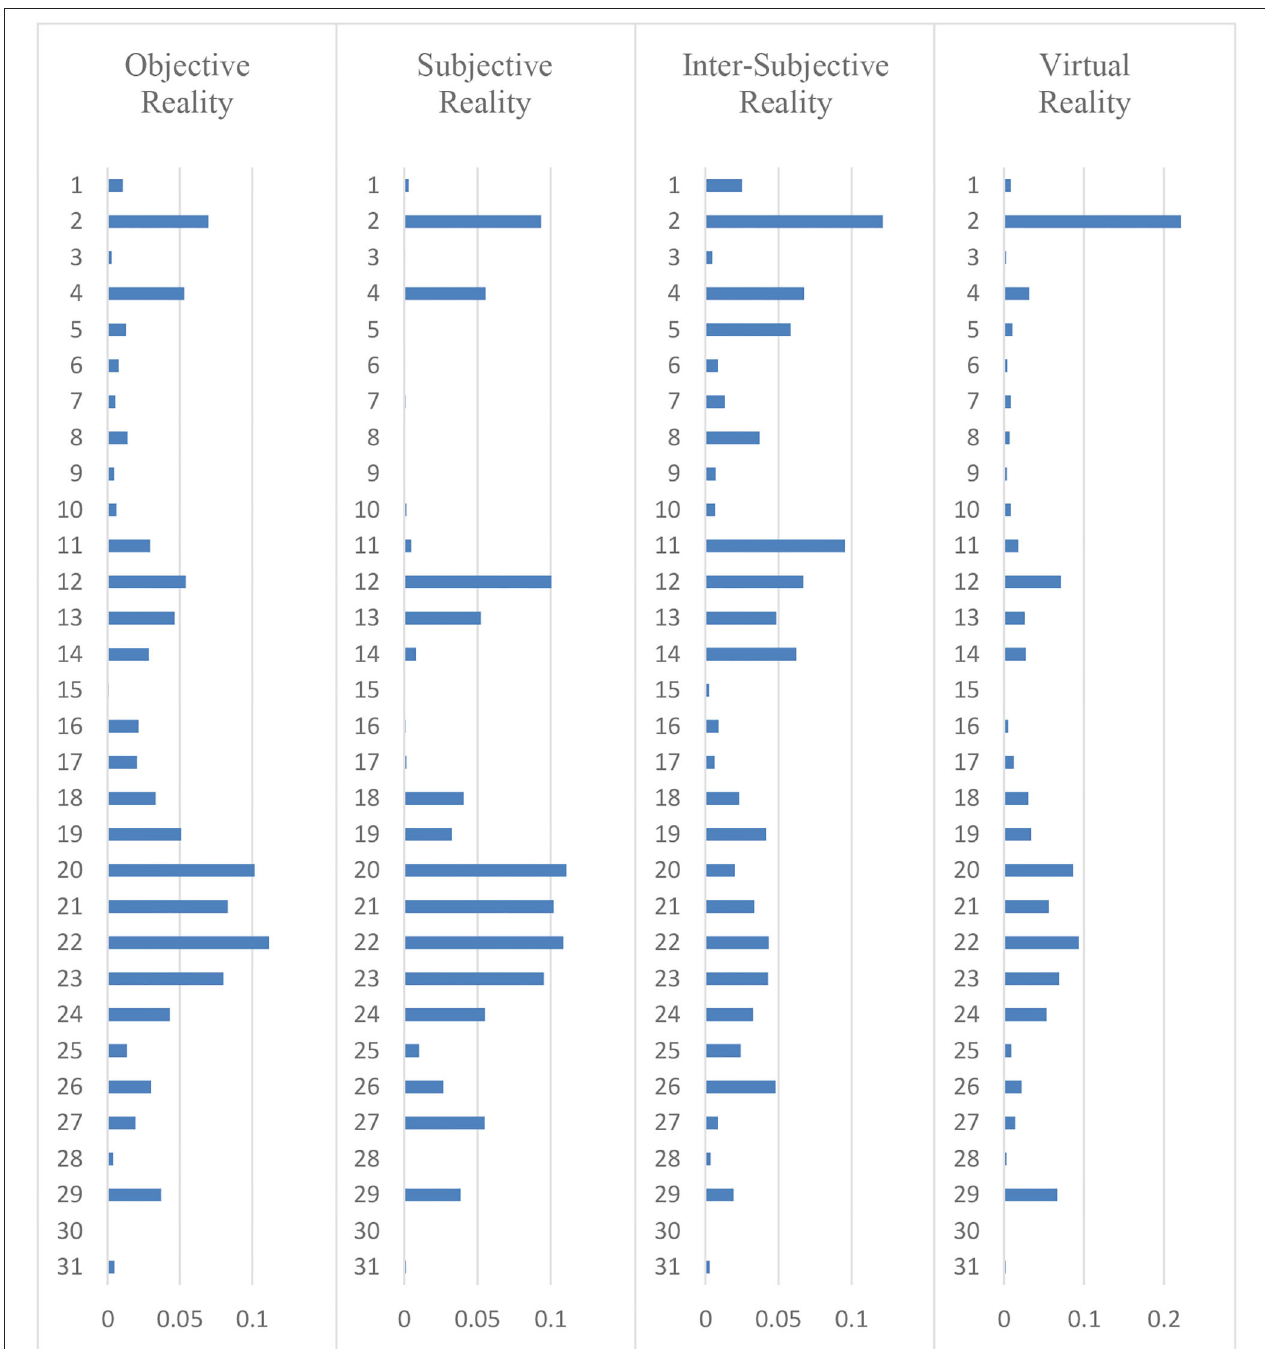
FIGURE 3 | Structure of and difference among the four happiness dimensions from posts datasets.